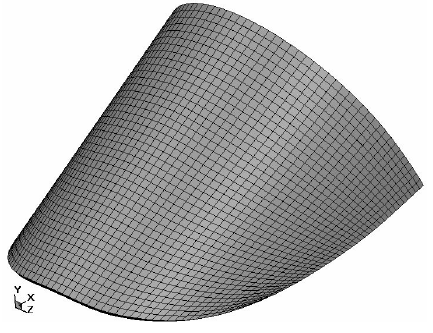
Fig. 4. FE model of windshield.